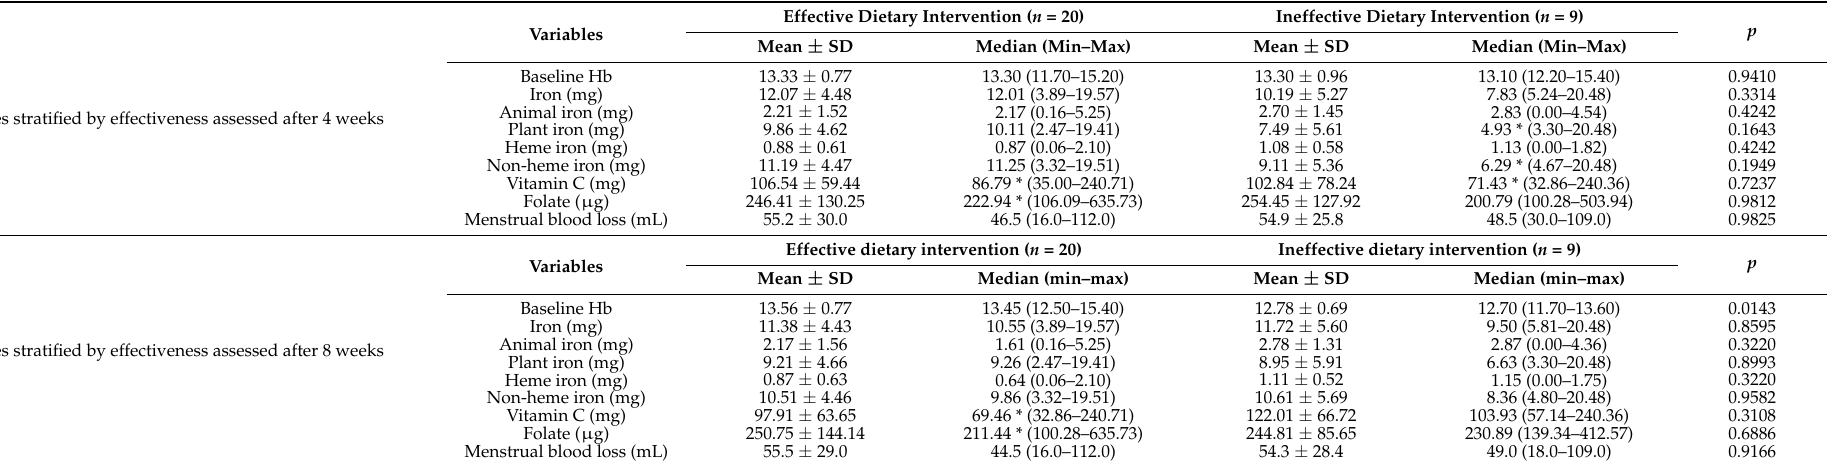
Table 5. The comparison of the baseline characteristics of the subsamples (hemoglobin level, dietary intake, and menstrual blood loss) in subsamples stratified by the effectiveness of dietary intervention assessed for hemoglobin level after 4 and 8